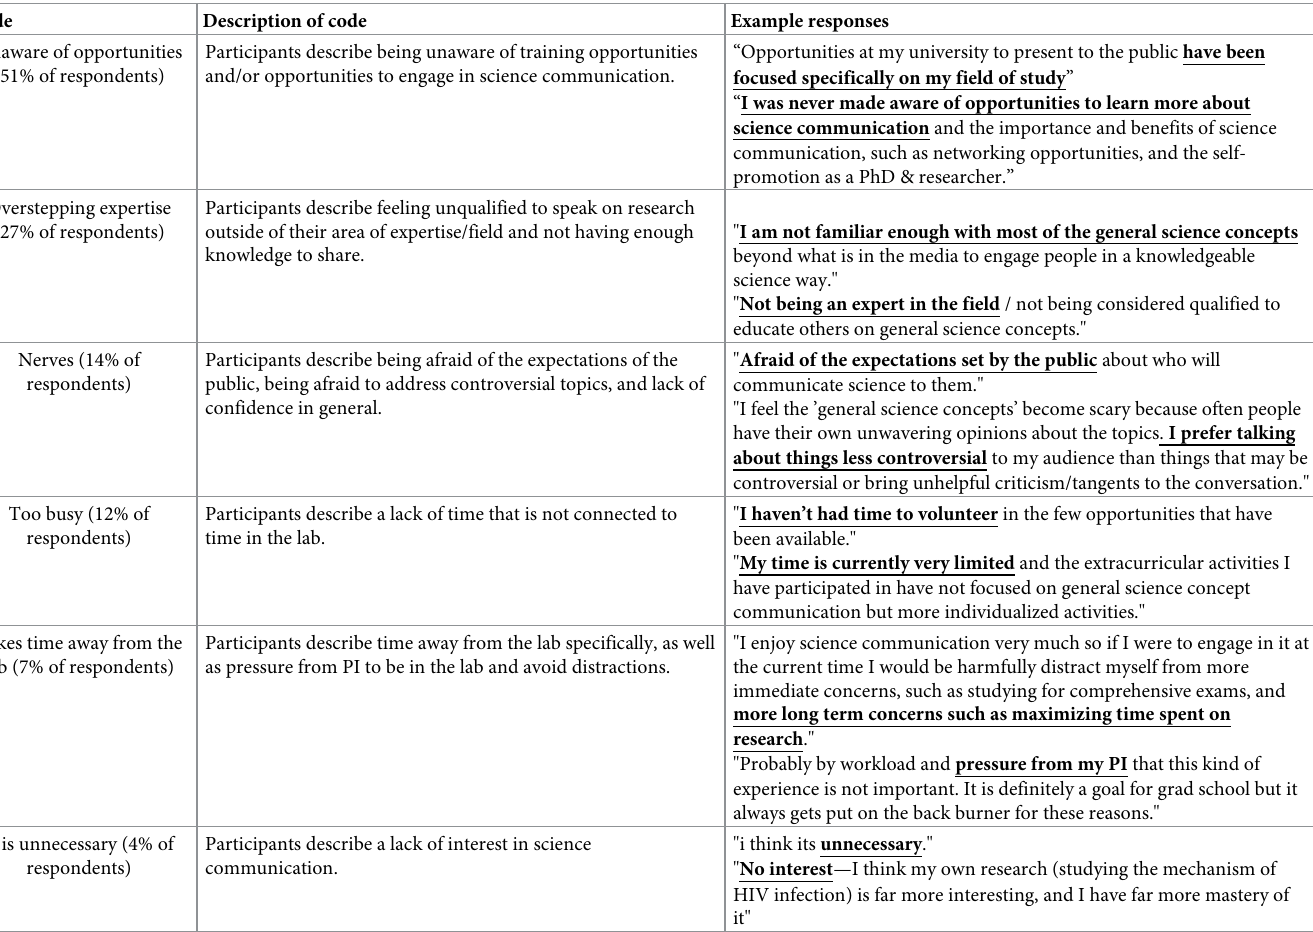
Table 5. Participant responses to the question “what has stopped you from engaging in science communication related to a general science concept?” the resulting codes are shown in the left hand column, with a description of each code in the center column, and example responses from participants in the right hand column. Text from each response that is directly relevant to each code is in bold and underlined